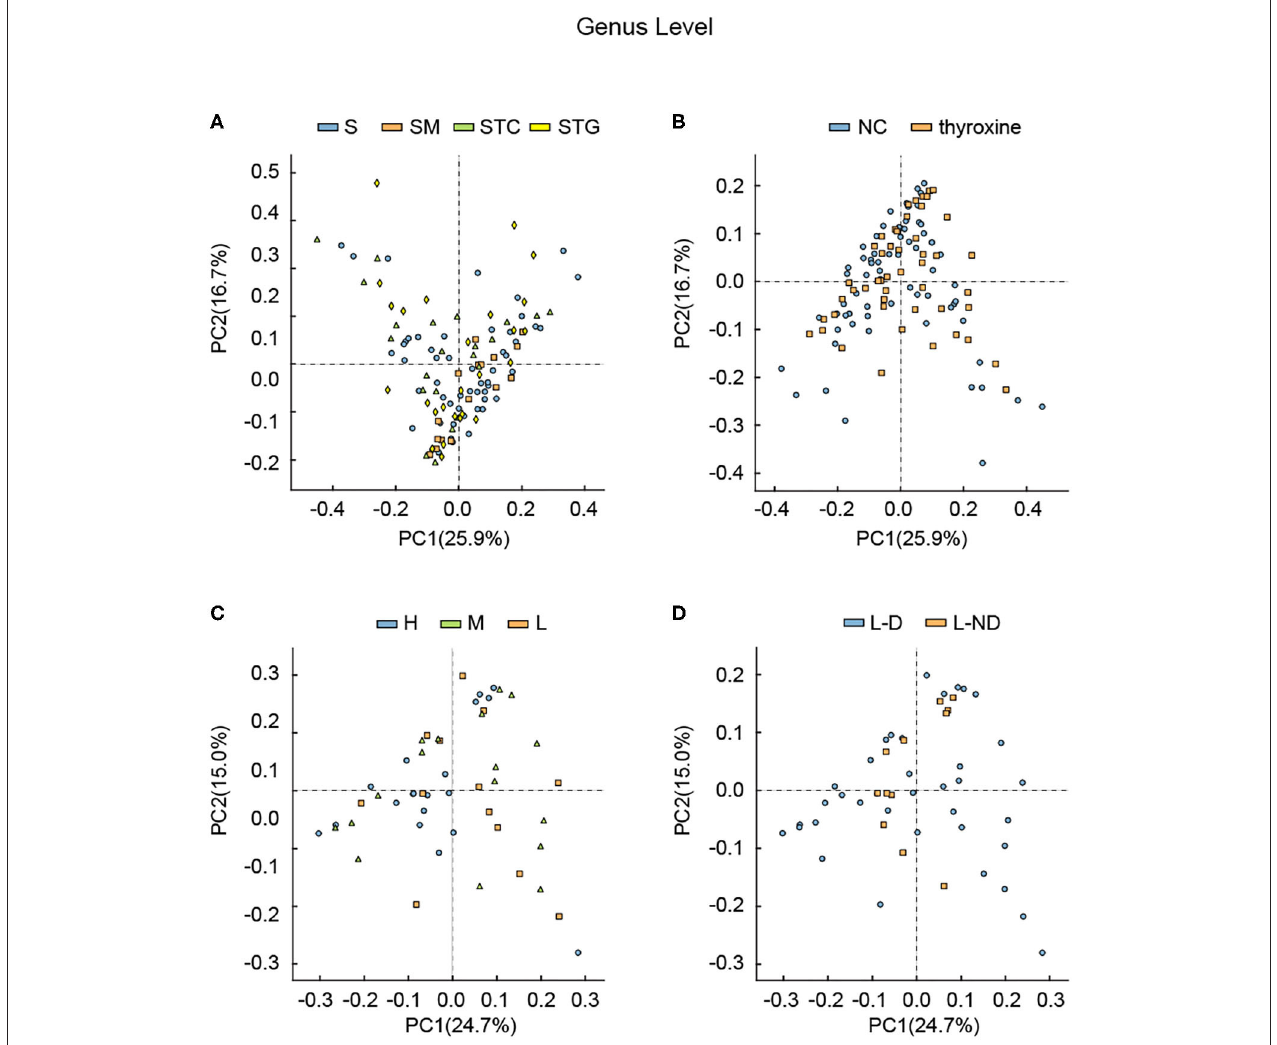
FIGURE 2 | Principle component analysis among different groups divided by (A) lipid profile, (B) with or without L-thyroxine treatment, (C) L-thyroxine dosage within the LRT group, and (D) the development of L-thyroxine dosage within the LRT group in genus levels. X- and Y-axes represent the first principal component (PCA1) and the second principal component (PCA2), respectively. The percentage in the brackets represents the relative contribution of the component to the total difference. Each sample corresponded to one dot in the graph. Different group is represented by different